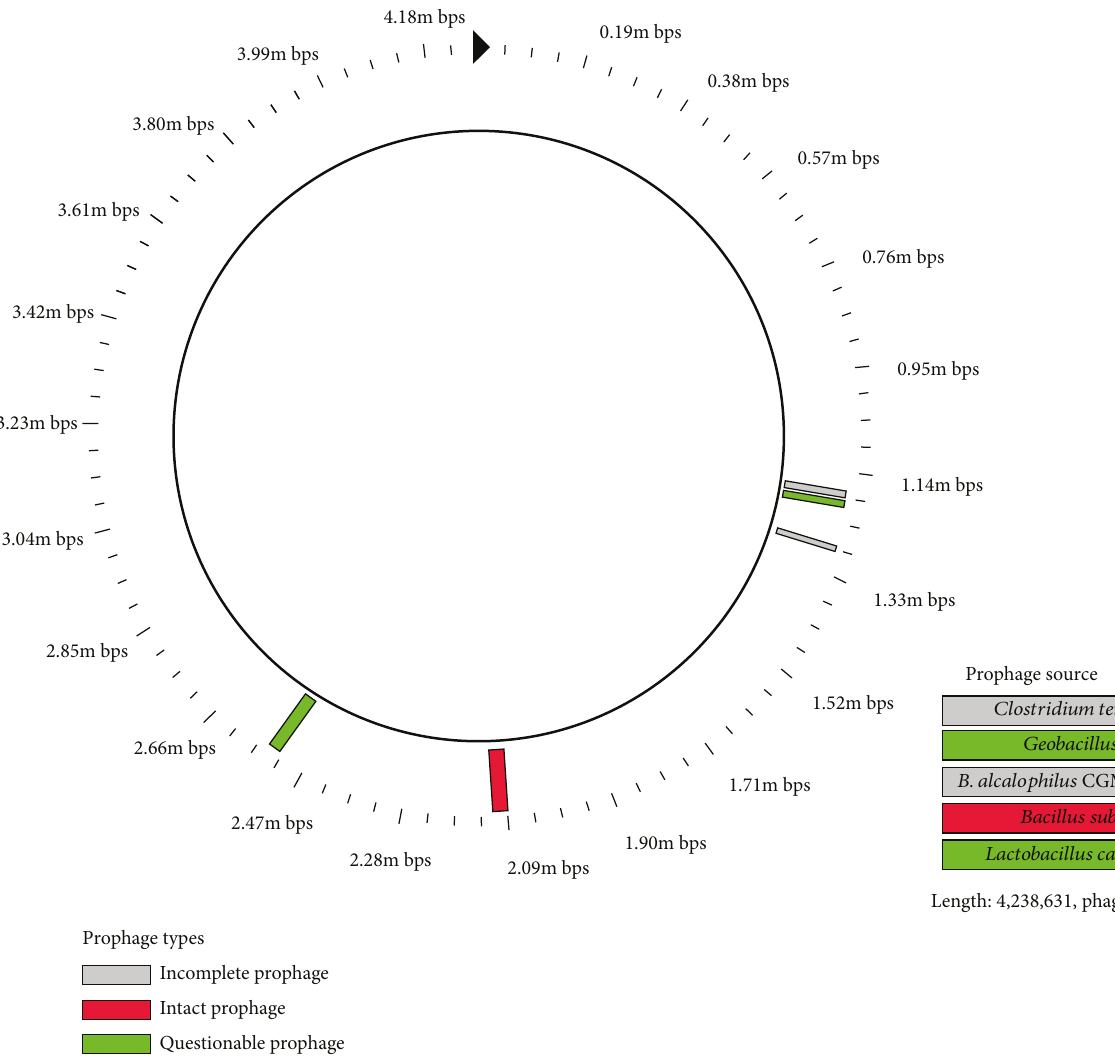
Figure 6: Characteristics and position of the prophage found in the Bacillus subtilis DM2 genome. The color in the circles represents the completeness of the prophage, incomplete prophage (gray-colored), intact prophage (red-colored), and potential prophage